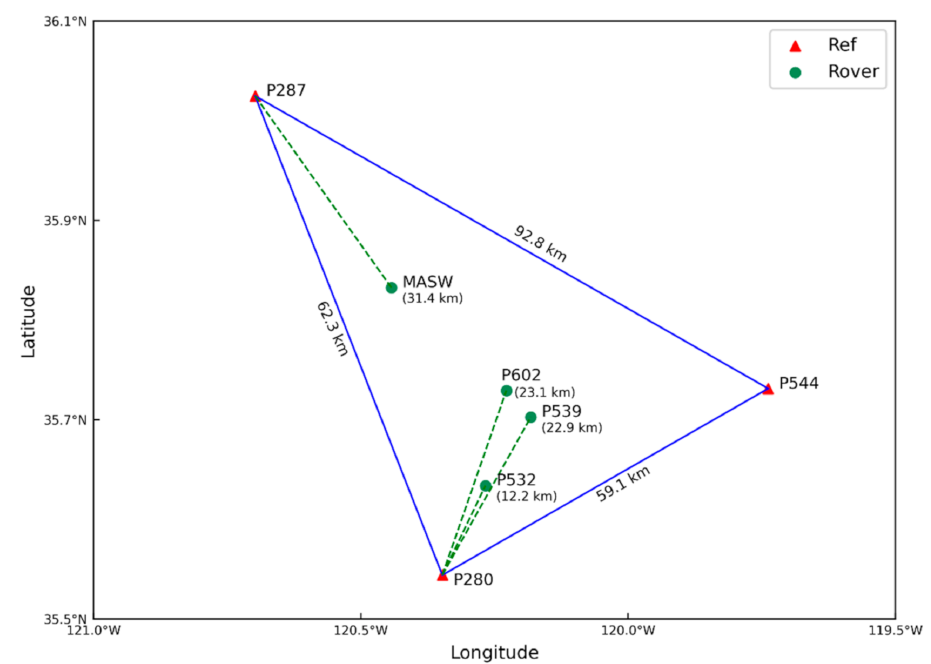
Figure 2. Geographical distribution of the selected stations in Dataset